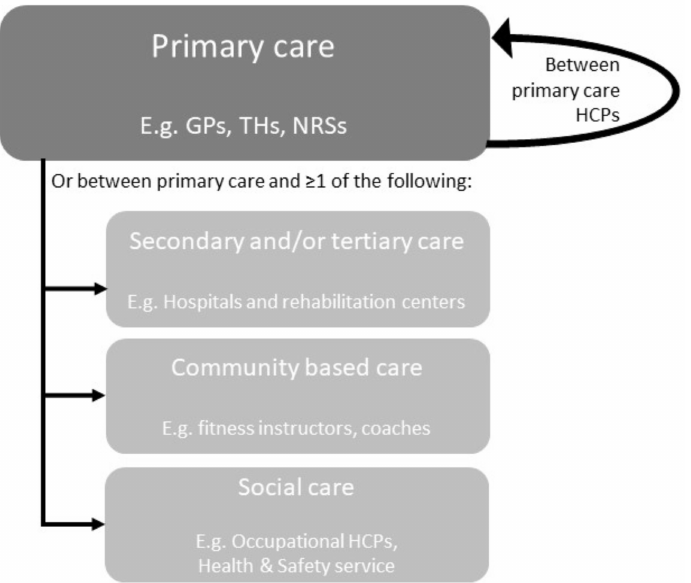
Figure 1. Overview of interdisciplinary care networks. GPs = general practitioners; THs = therapists; NRSs = nurses; HCPs = health care